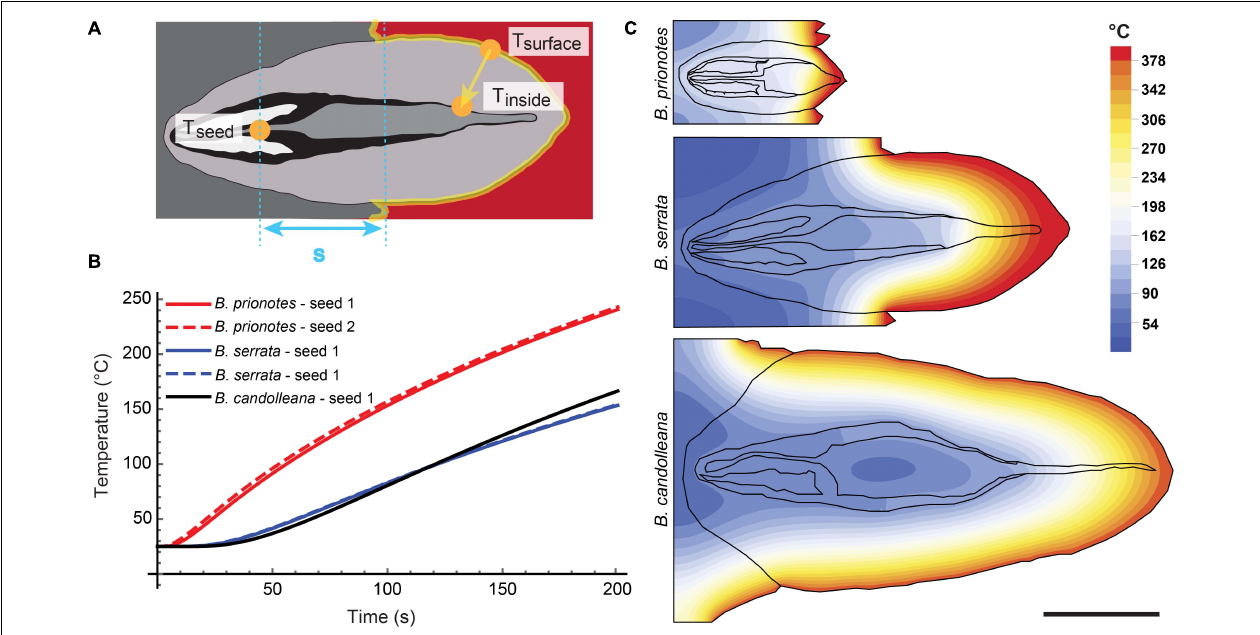
FIGURE 6 | Simulation of heat transfer in closed follicles. (A) Schematic drawing showing the relevant locations for temperature measurements and calculations in a closed follicle. (B) Seed temperatures as a function of time for the three species, obtained from simulations with initial temperature gradients similar to the experimental burns: (cid:49) T ( B. prionotes ) = 414 ◦ C ( Figure 2A1 ); (cid:49) T (B. serrata) = 431 ◦ C ( Figure 2B2 ); (cid:49) T ( B. candolleana ) = 376 ◦ C ( Figure 2C1 ). (C) 2D simulations for all three species showing the local temperatures at t = 180 s with the same parameters used as in B. In the simulation, the follicles remained closed and different material parameters were only assigned to air; all solid components have the same properties (valves, separator, seeds, embedment) to reveal the role of geometry. Scale bar: 1 cm